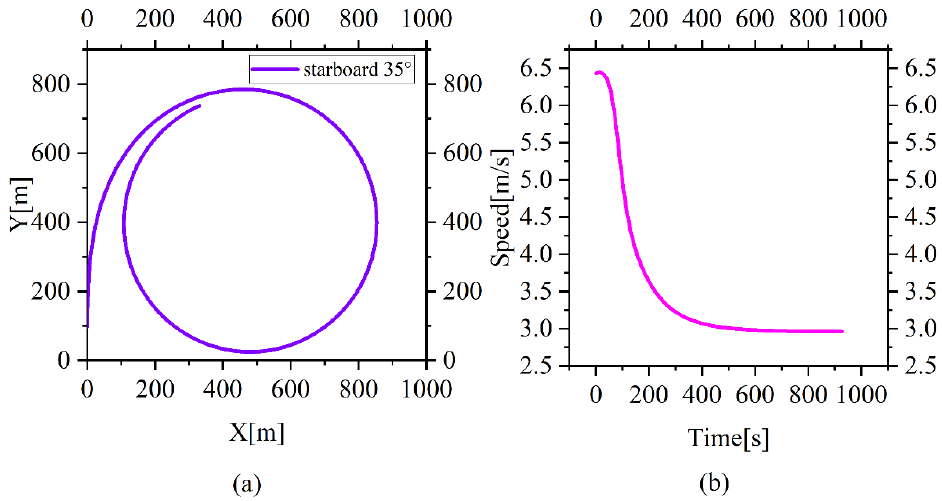
Figure 9. Simulation of turning circle. ( a ) ship trajectory at starboard 35°; ( b ) tendency of speed.